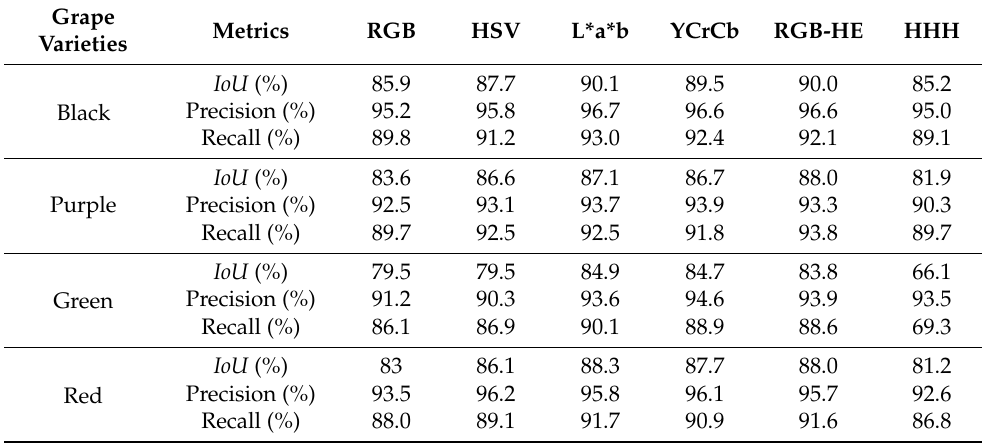
Table 8. The performance of different grape varieties on different datasets. Grape